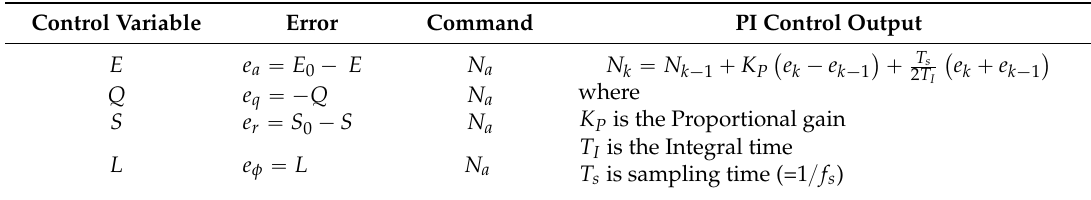
Table 7. Design of PI Controller.